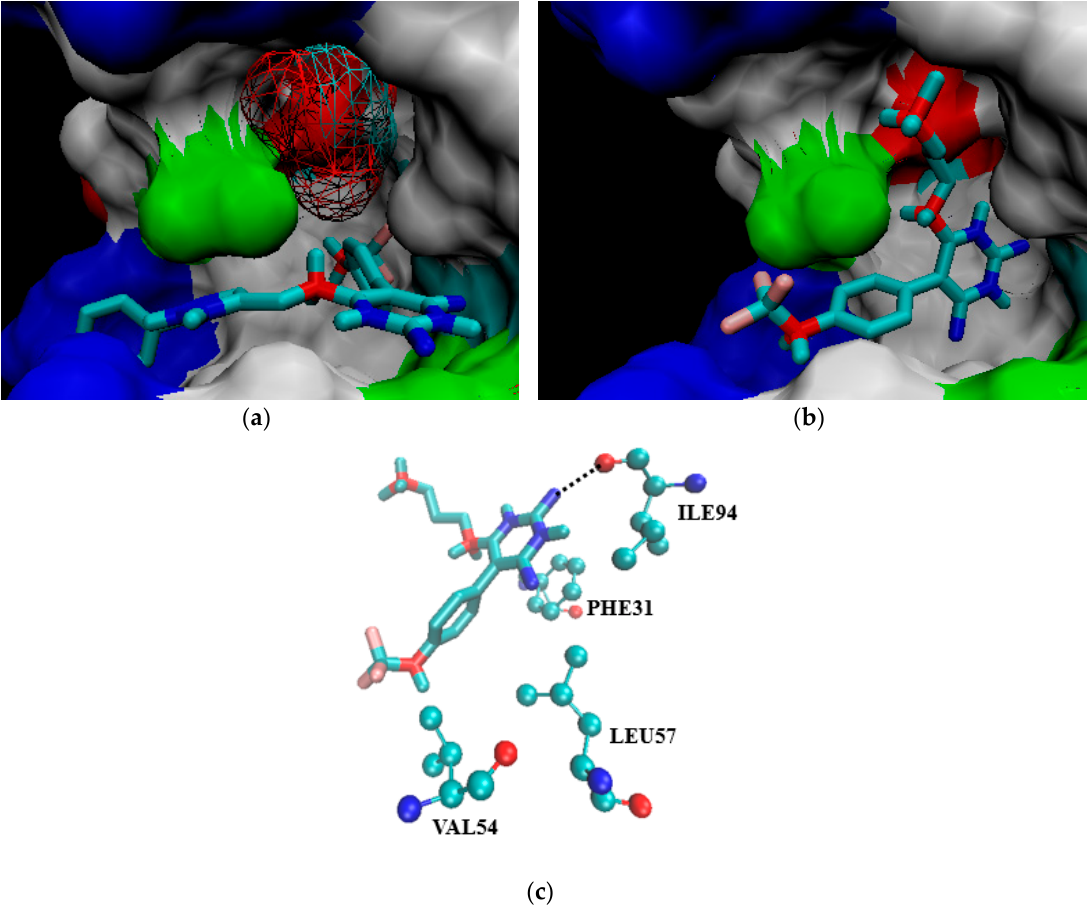
Figure 3. ( a ) Compound 16m with large side chain group and the binding sites of glycerol (GOL) in mt -DHFR, in which compound 16m is represented as a sticks model, GOL as a dotted line model and protein as a molecular surface; ( b , c ) the small side chain group of compound 16f can fit into the GOL binding site, in which the molecule is represented as sticks and protein as a molecular surface.